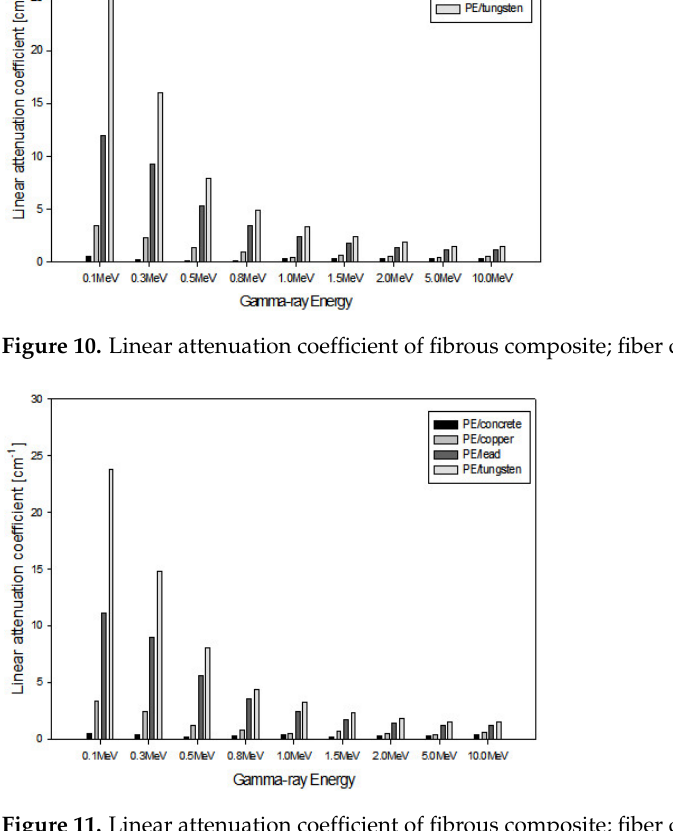
Figure 12. Linear attenuation coefficient of fibrous composite; fiber diameter 0.1128 cm.